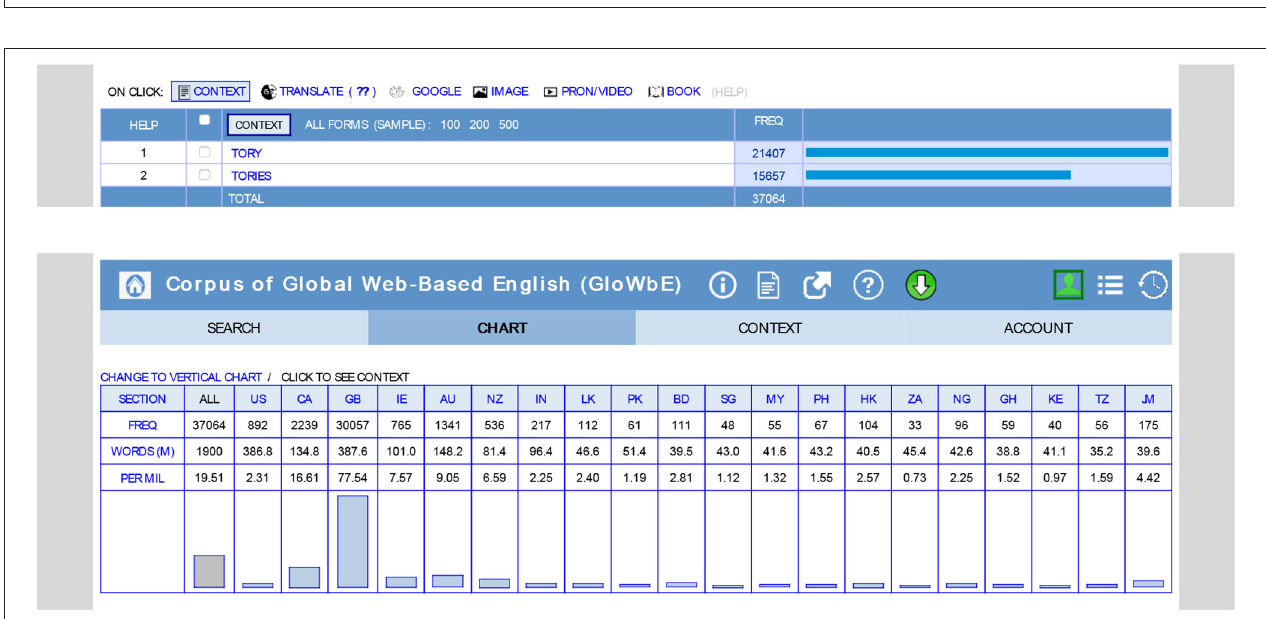
FIGURE 19 | Distribution of donnybrook in the GloWbE Corpus (from https://www.english-corpora.org/glowbe/).